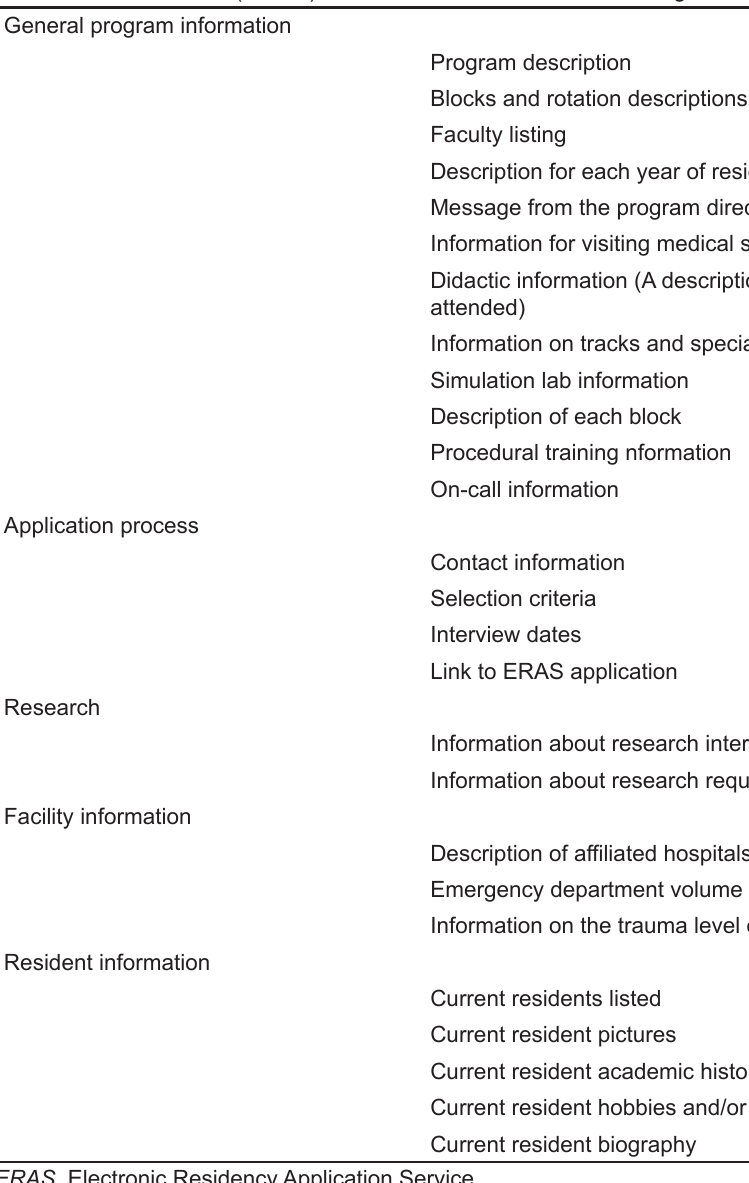
ERAS, Electronic Residency Application